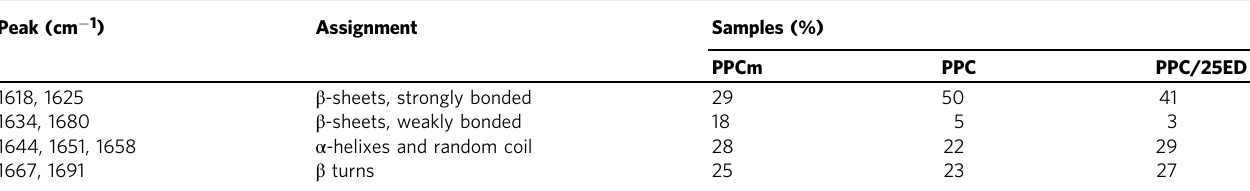
Table 1 Relative content of protein secondary structure (%) from the FT-IR curve resolution. Peak (cm − 1